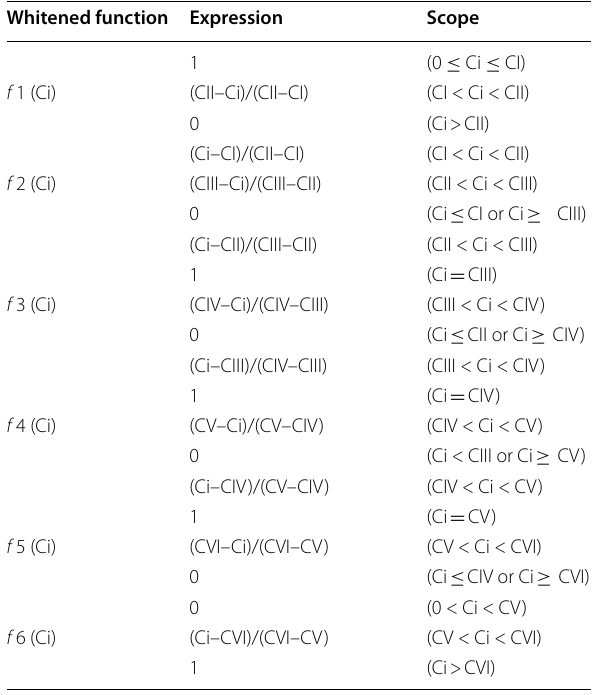
Table 2 Whitened functions for six grades Whitened function Expression Scope